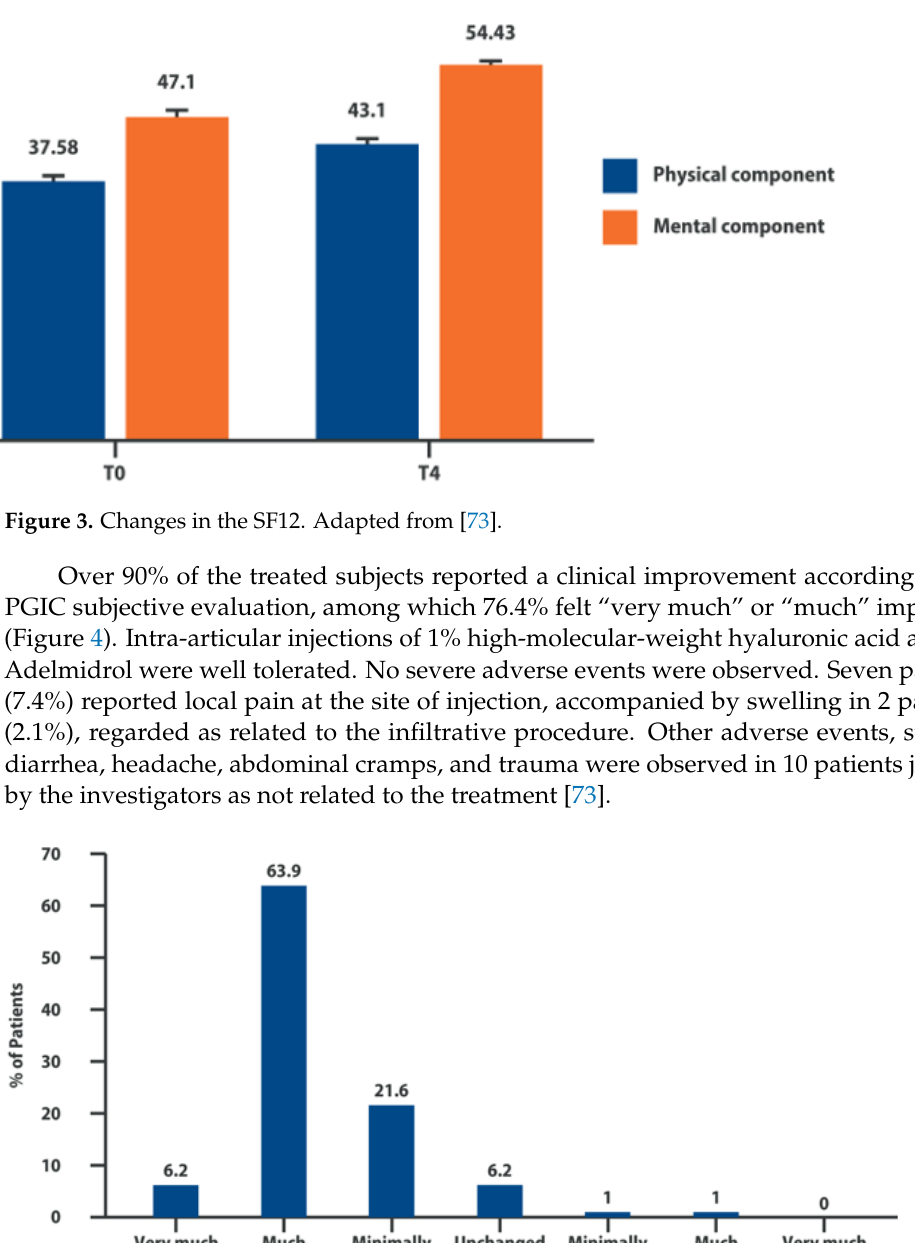
Figure 4. Patient Global Impression of Change. Adapted from [69].